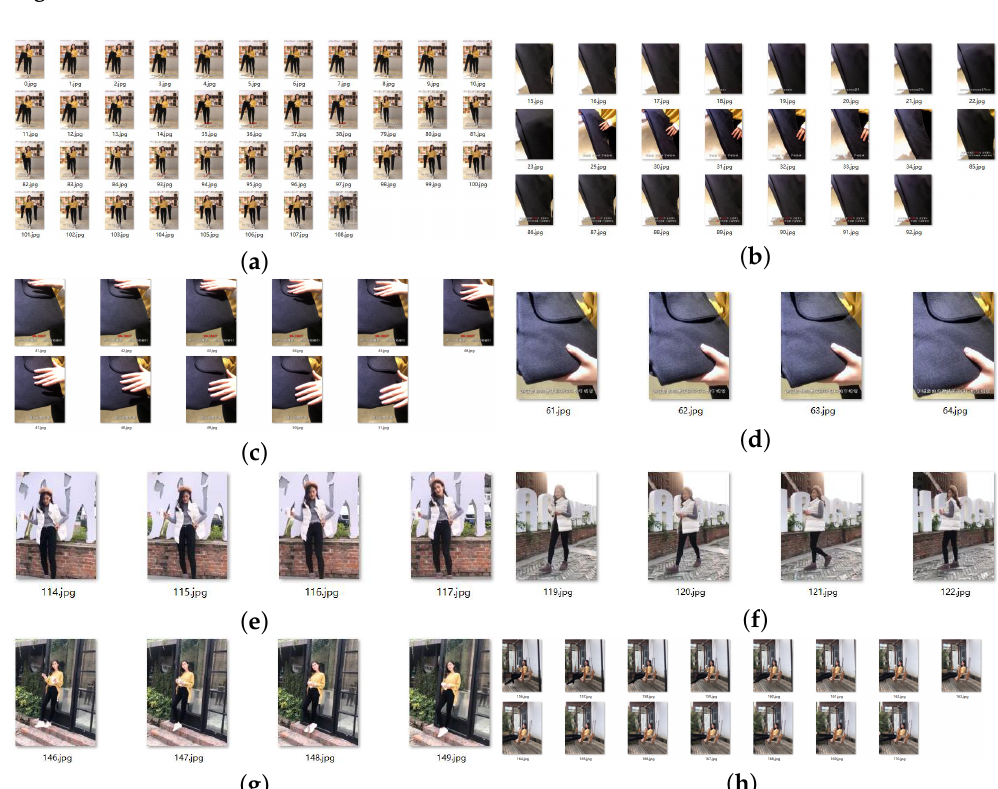
Figure 8. ACBD clusters the differential frames into 8 clusters ( a – h